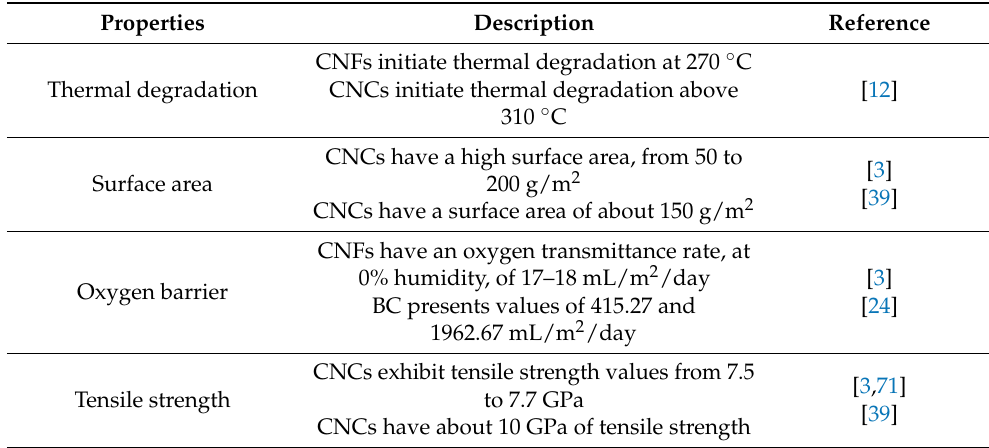
Table 6. Numerical values of some nanocelluloses’